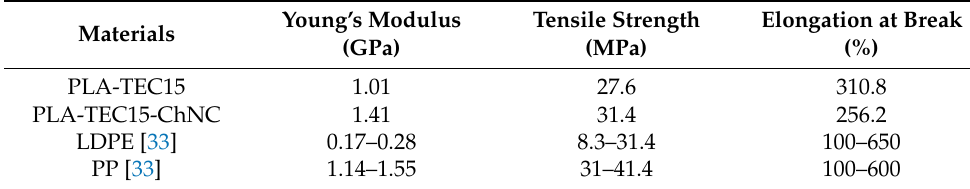
Table 4. Mechanical properties of commonly used petroleum-based polymers.